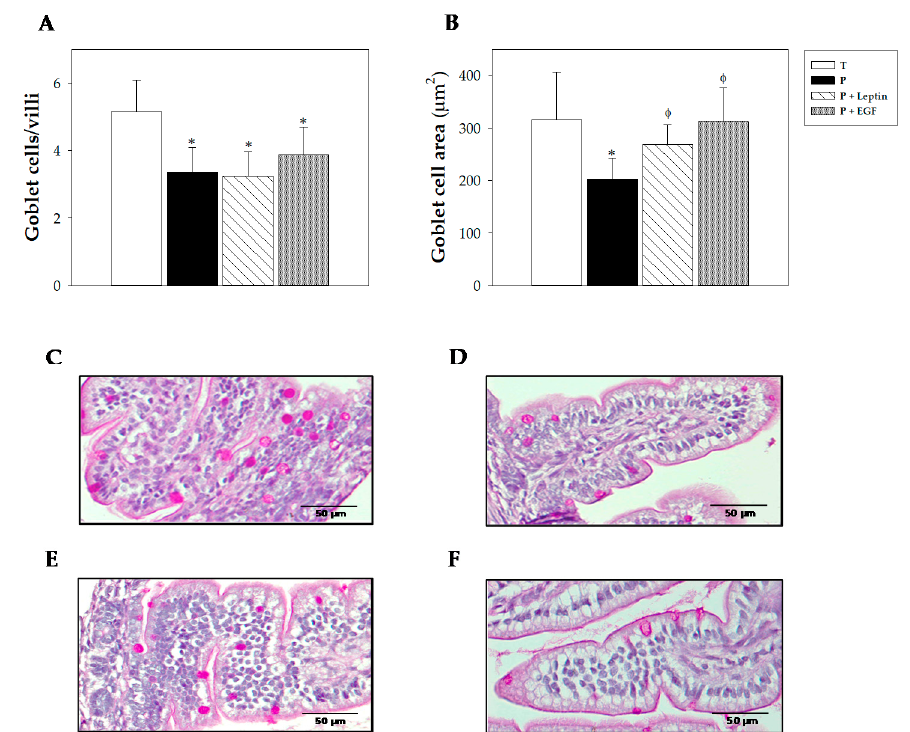
Figure 8. Number of goblet cells/villi ( A ), goblet cells area ( B ), and representative images of histological sections of the jejunum with periodic acid − Schi ff (PAS) staining from the four groups: Term ( C ), Preterm ( D ), P+Leptin ( E ), and P+epidermal growth factor (P+EGF) ( F ) at day 10 of the suckling period. Results of Figure 8A,B are expressed as mean ± SD ( n = 6 pups/group). Statistical differences: * p < 0.05 versus T group; φ p < 0.05 versus P group. Goblet cells with densely